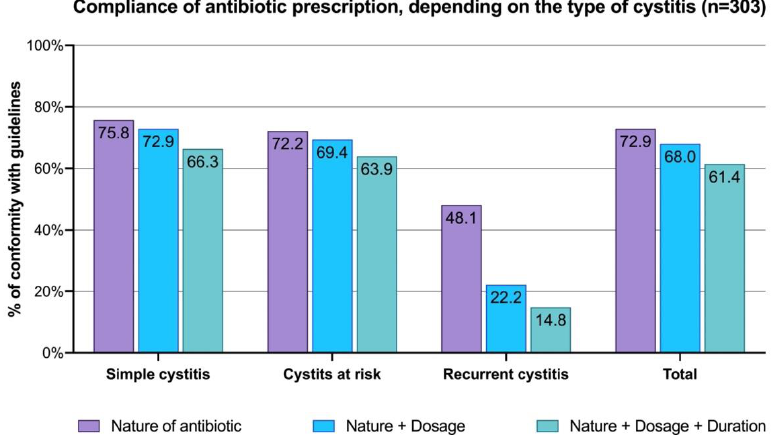
Figure 2. The compliance of antibiotic prescription, depending on the type of cystitis: uncomplicated cystitis, cystitis at risk of complication, and recurrent cystitis (n = 303). Compliance was examined based on the nature of the antibiotic, the nature and dosage of the antibiotic, or the nature, the dosage, and the duration of the antibiotic with the guidelines. To assess the association between some variables and the compliance of antibiotic therapy (nature, dosage, and duration), a logistic regression was performed (Figure 3). Ages between 56 and 65 years and having a prescription left with the office secretary in- creased the risk of non-compliance (with an OR of 2.6 and 4.52, respectively). Conversely, the absence of a urine culture slightly but significantly reduced non-compliance (with an OR between 0.58 and 0.99). Finally, the absence of a risk factor in the patient remains the criterion that most reduced non-compliance with antibiotic therapy (with an OR of 0.08).